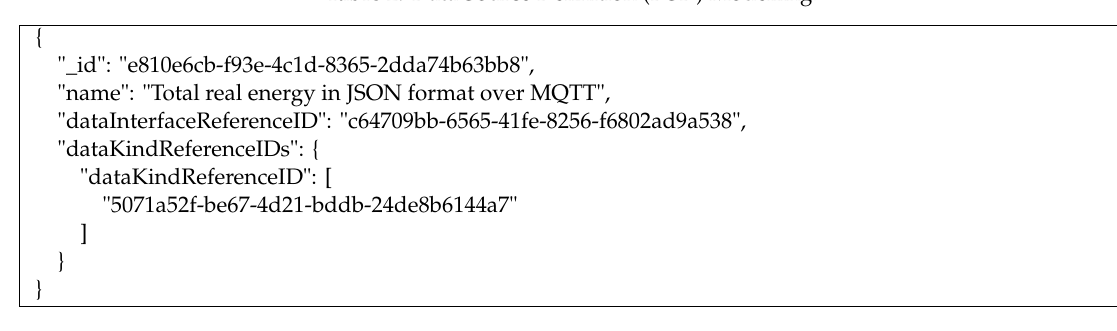
Table 2. Data Source Definition (DSD) Modelling.